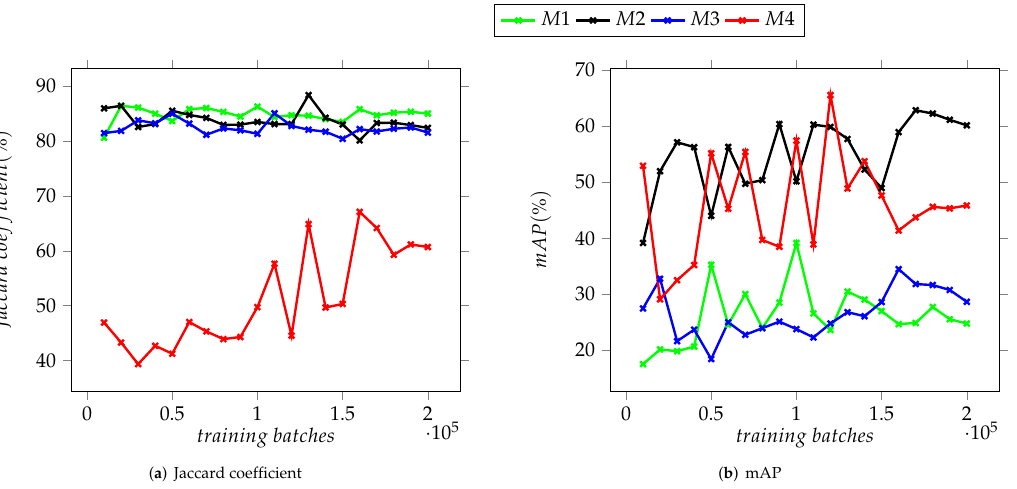
Figure 9. Average Jaccard coefficient and mAP for the trained detection models on validation Dataset II.